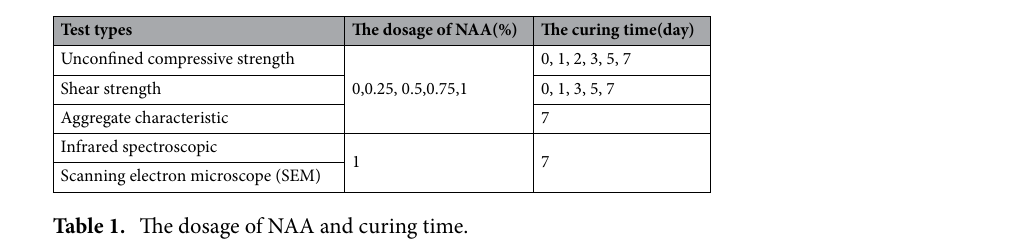
Table 1. The dosage of NAA and curing